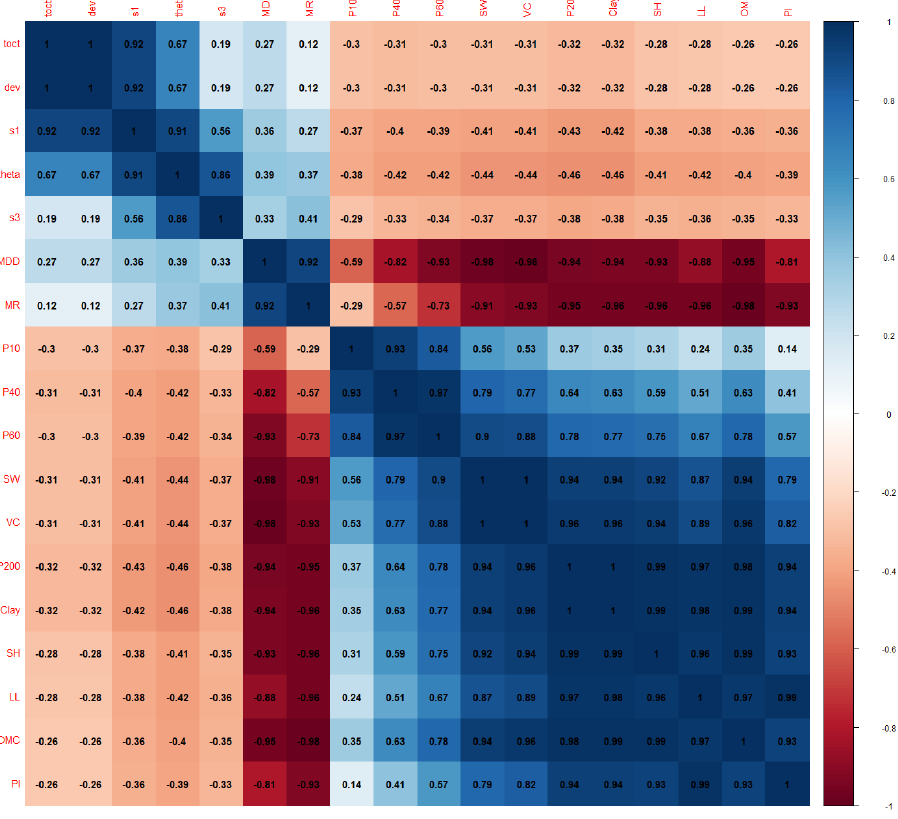
Figure 3. Correlation matrix of variables. (Note: the correlation coefficient values only show up to two decimal